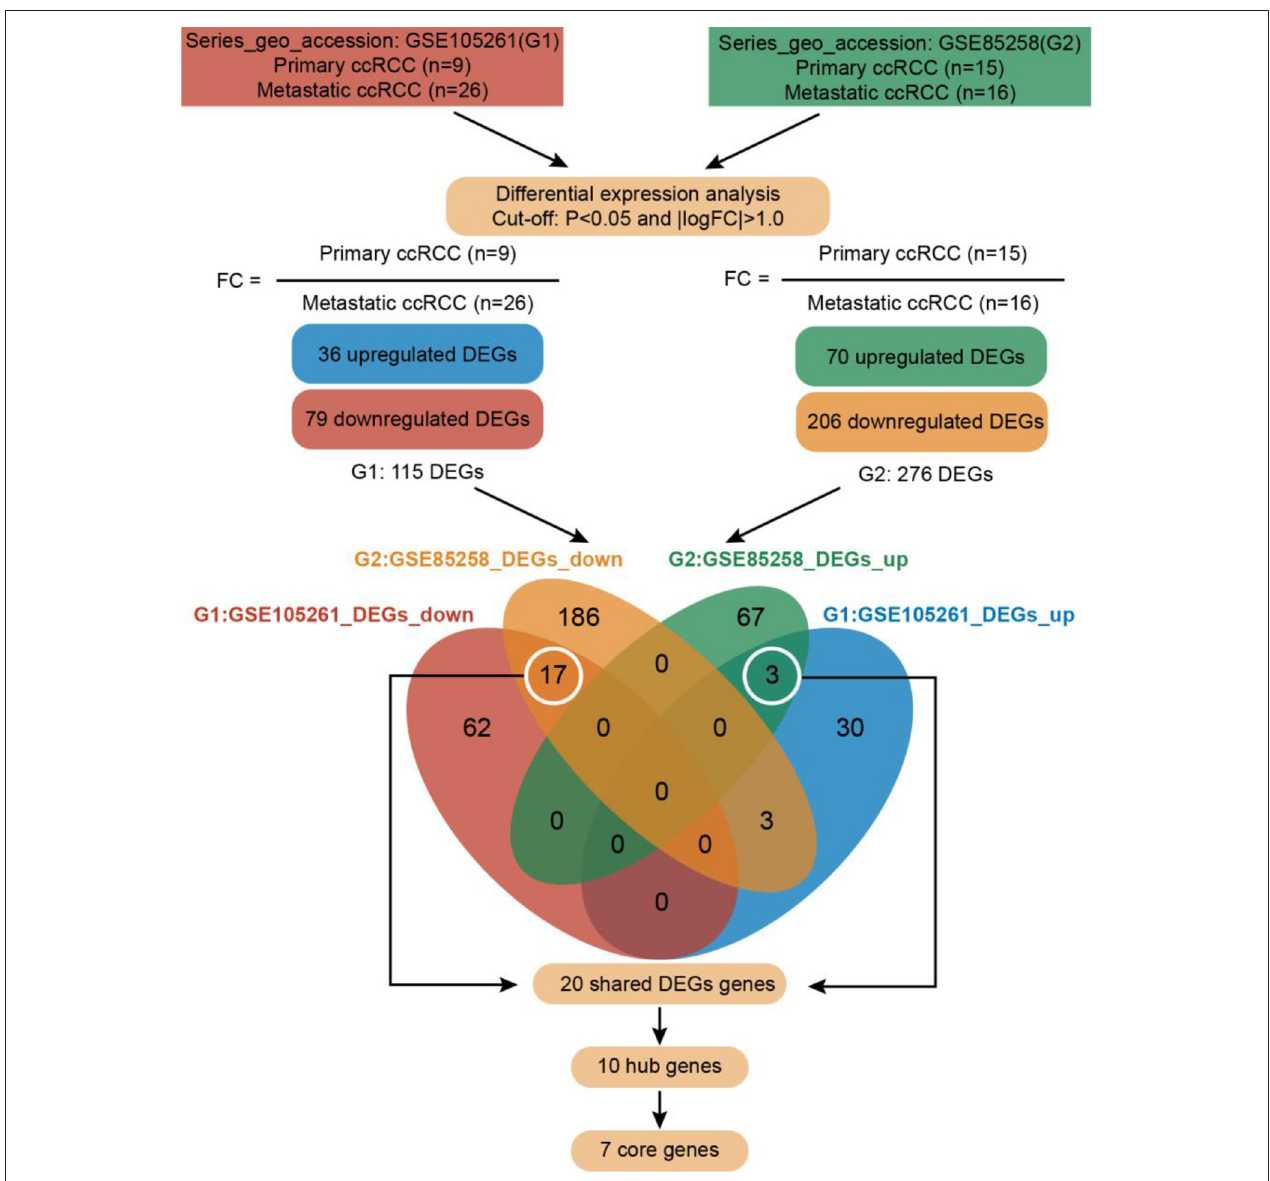
FIGURE 1 | Roadmap of the approach and summarized findings.